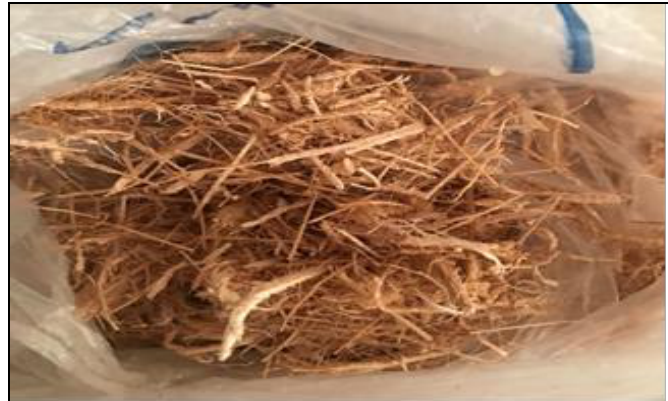
Figura 3: Fibra da palmeira de buriti. Fonte: Autores,